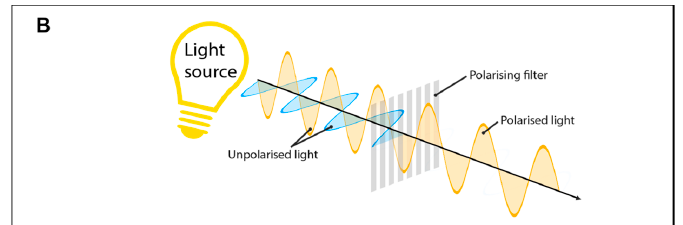
Figure 1. Properties of light. ( A ) Graphic illustration of two different spectra with respective color metrics. The blue spectrum has a peak wavelength of 420 nm whereas the red spectrum has a peak wavelength of 620 nm. Thus, the hue of the blue spectrum is 420 nm and the hue of the red spectrum is 620 nm. The blue spectrum spans a shorter range of the spectrum and thus is more chromatic than the broader red spectrum. The shading under each spectrum represents overall brightness and as the red spectrum is larger than the blue spectrum, it has a greater brightness. For a more in-depth description of color parameters and formulae, see [21]. ( B ) A graphic representation of polarized light. A light source produces unpolarized light, in which the e-vectors of light are oriented randomly, then as the light travels through the filter, only light in one orientation is transmitted resulting in polarized light. Figure 1( B ) was adopted from physics.stackexchange.com ©.